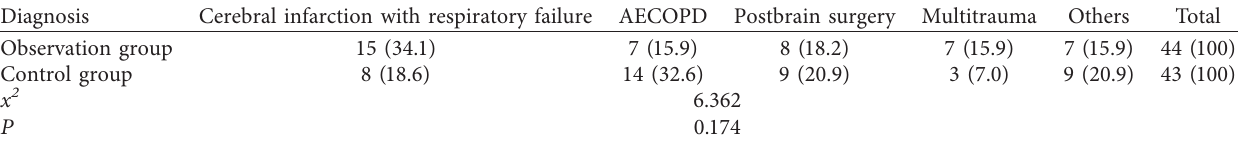
Table 1: Disease composition ( n ,